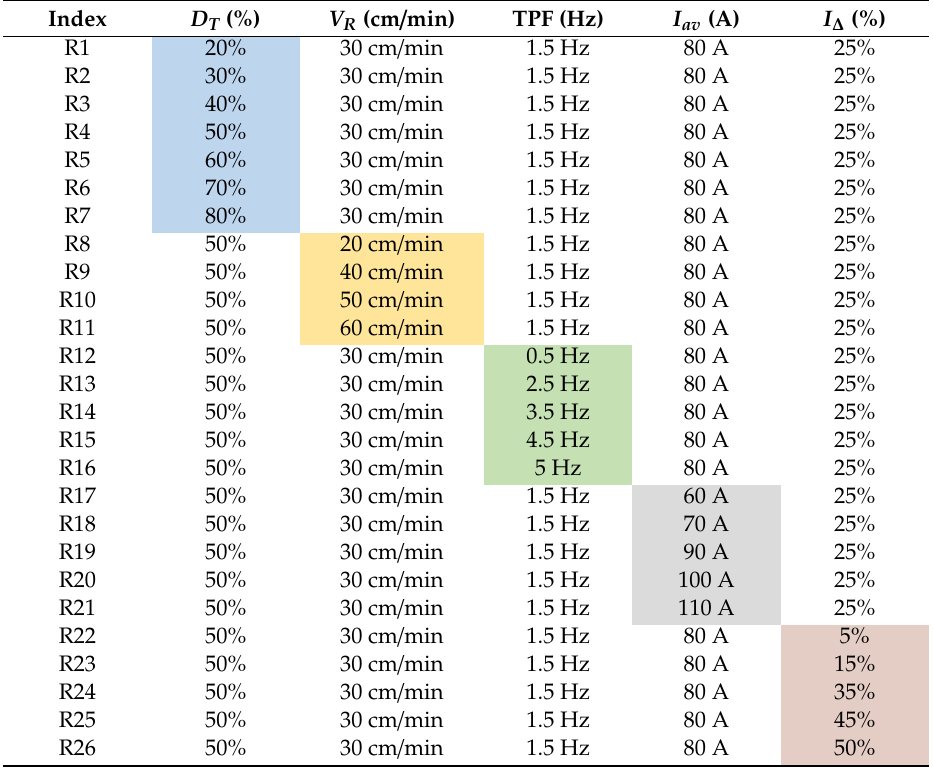
Table 2. Experimental program of the selected process